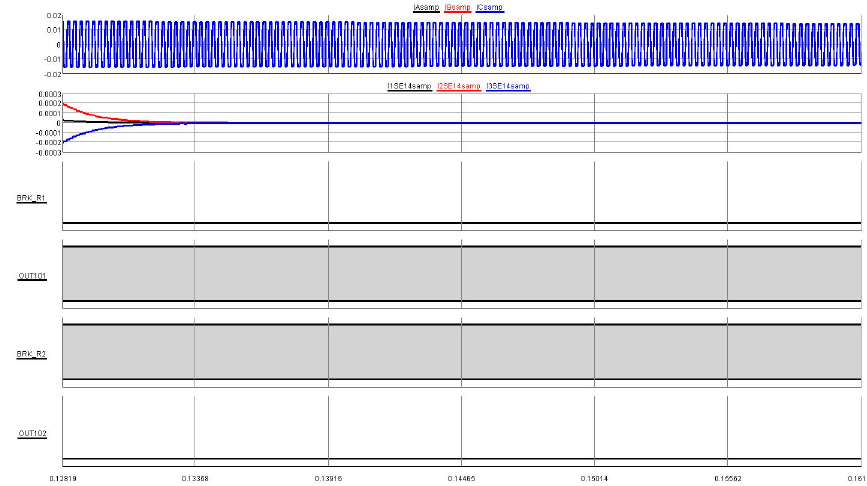
Figure 27. Waveforms for post-fault condition when R1 operates—case 2.